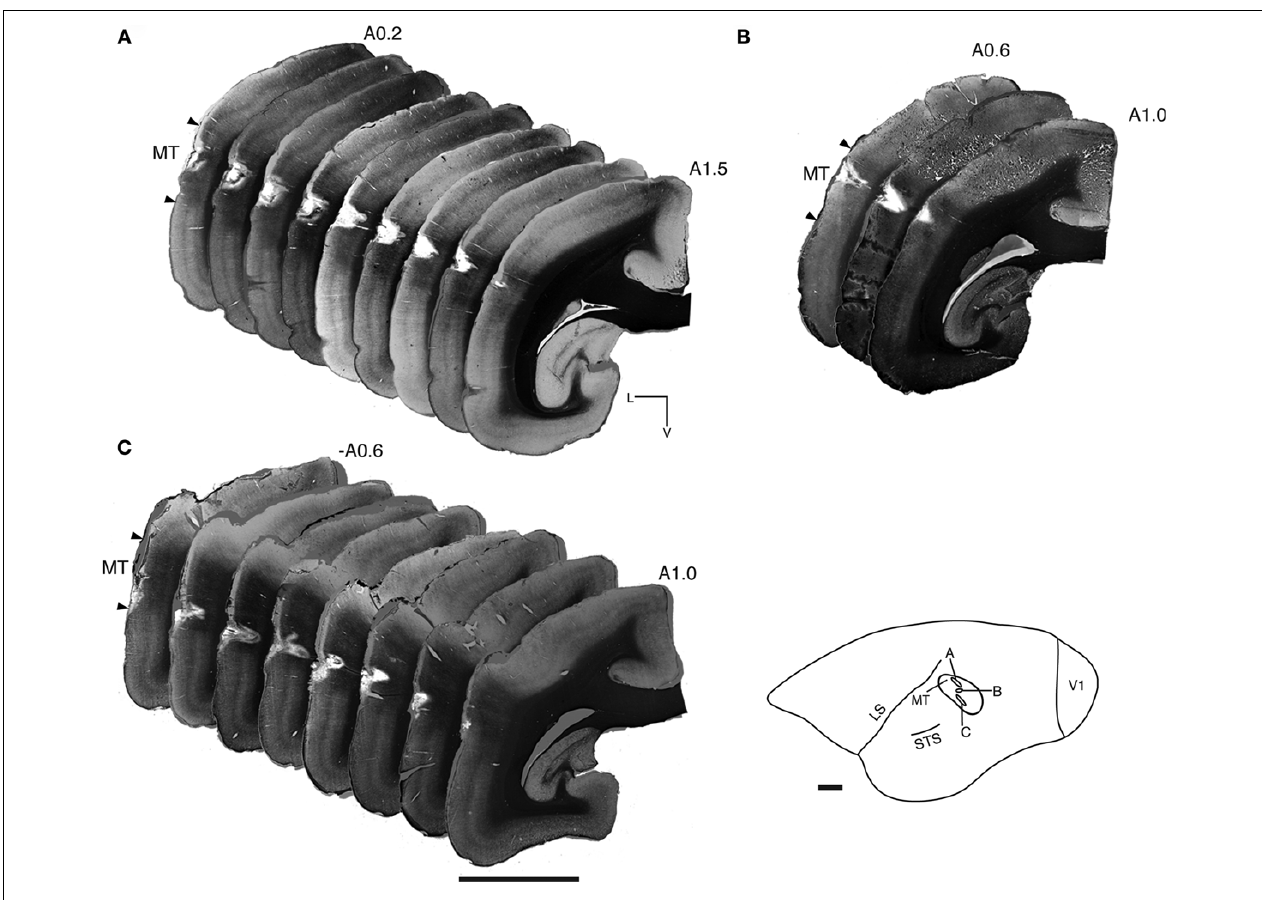
FIGURE 3 | Myelin-stained coronal sections enables identifi cation of area MT and ensures accurate placement of Fast Blue injections. (A) NM53 A0.2–1.5 mm, crystal insertion. (B) NM55 A0.6–1.0 mm, micropipette injection. (C) NM58 A0.6–1.0 mm, crystal insertion. These montages confi rm the correct placement of the Fast Blue in cortical area MT in all three cases, and